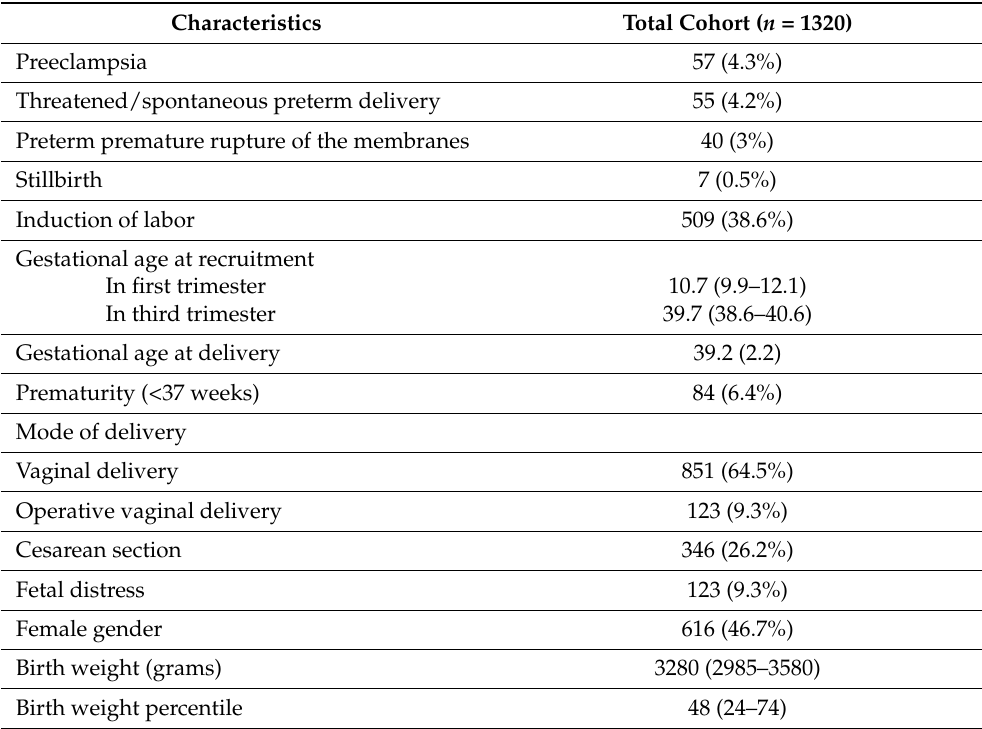
Table 2. Pandemic cohort pregnancy and neonatal outcomes.